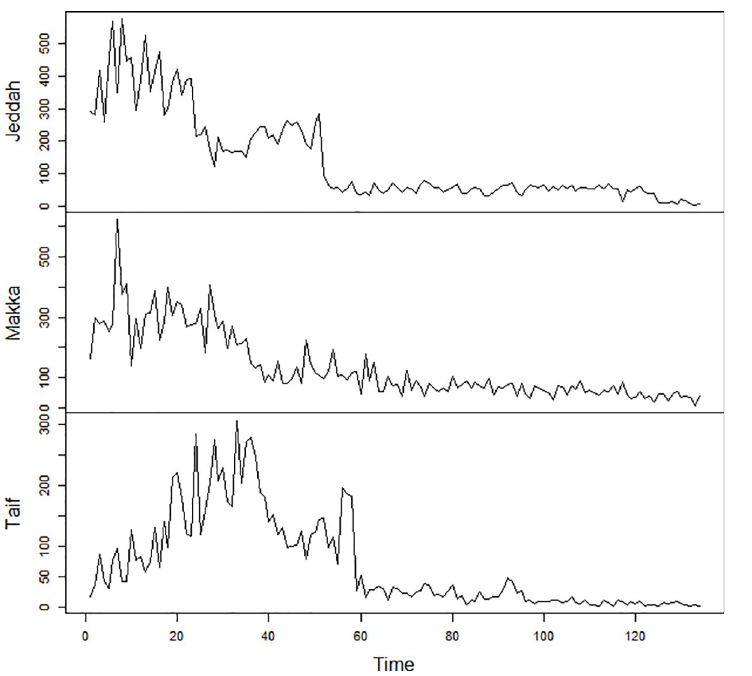
Fig 2. Time series plot of daily confirmed cases of